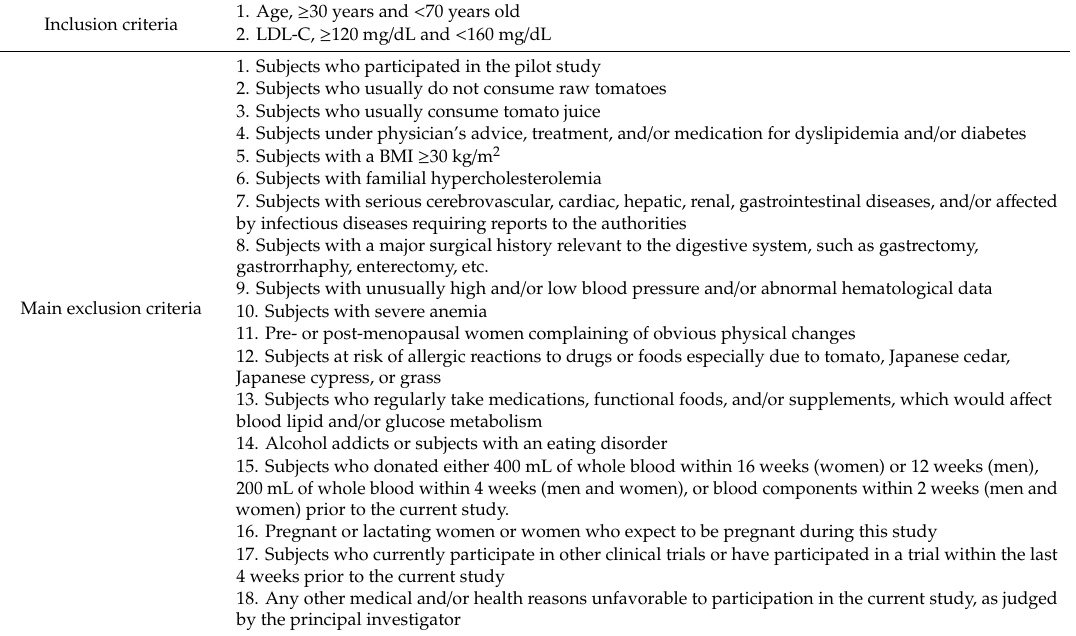
Table 2. Inclusion and exclusion criteria.